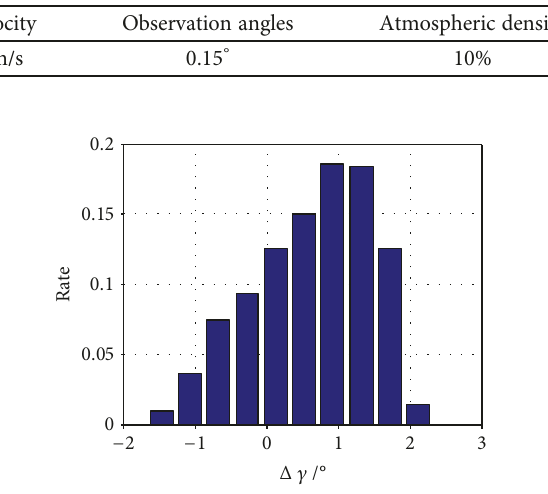
Figure 16: Distribution of path angle error.